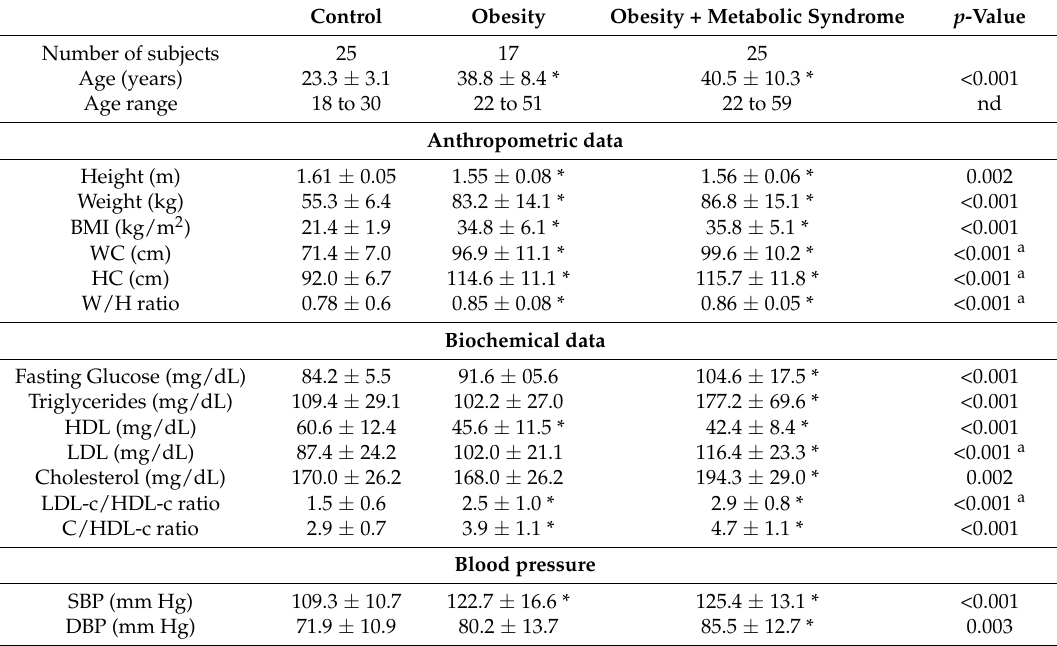
Table 1. Clinical characteristics of the studied